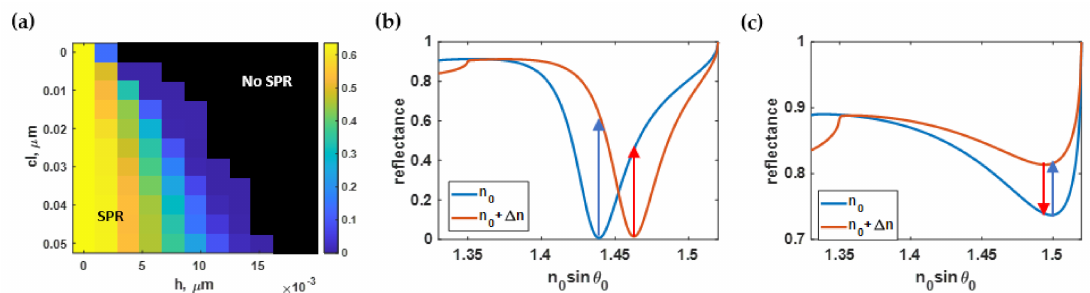
Figure 12. ( a ) The change in intensity calculated using Monte Carlo simulation; ( b ) SPR dips at h of 1 nm and cl of 50 nm with an average intensity difference of 0.62; and ( c ) and SPR dips at h of 7 nm and cl of 15 nm with an average intensity difference of